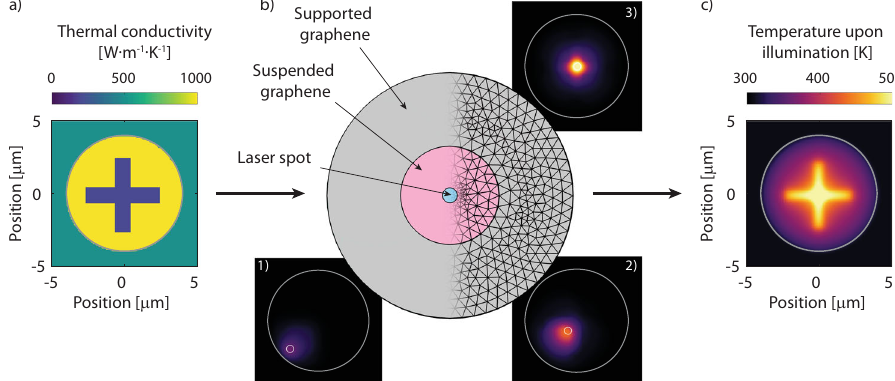
Fig. 3 Finite-element method description. a Input thermal conductivity map. b Schematic representation of the sample and the calculation mesh. Temperature pro fi les of the graphene membrane with the heating laser spot at three different positions (1 – 3). c Temperature pro fi le upon laser illumination.